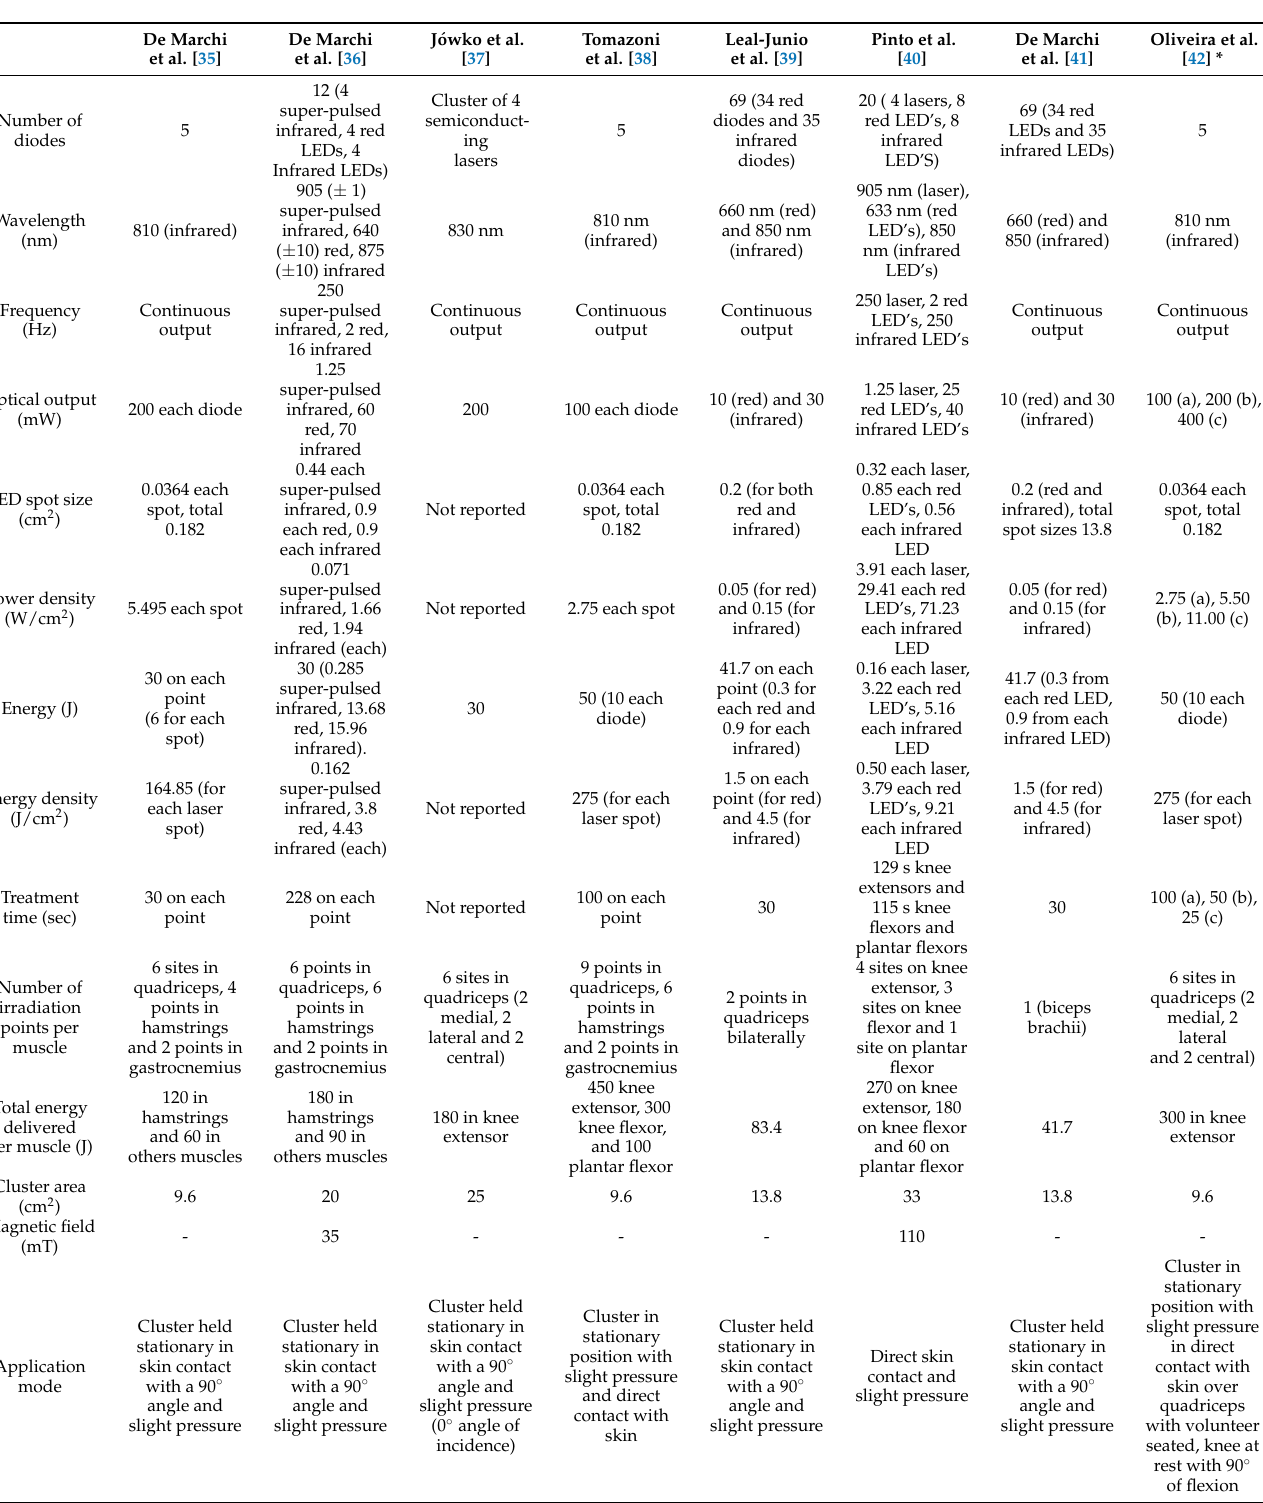
Table 2. Photobiomodulation therapy